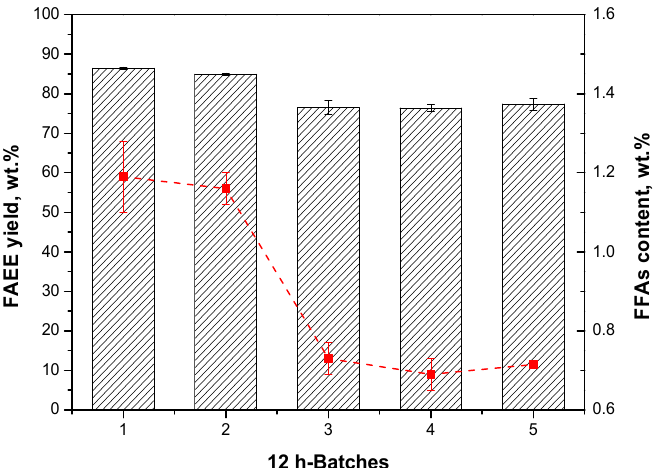
Figure 10. Reuse assay (12 h-cycles) of the Eversa-mCLEA in the transesterification of soybean oil (15 g) with ethanol (oil / ethanol molar ratio of 1:6), enzyme load 12 U est / g oil at 40 ◦ C, and 1700–2000 rpm stirring in a vortex flow reactor. Bars represent FAEE yields and the point-dashed curve represents the FFAs content.